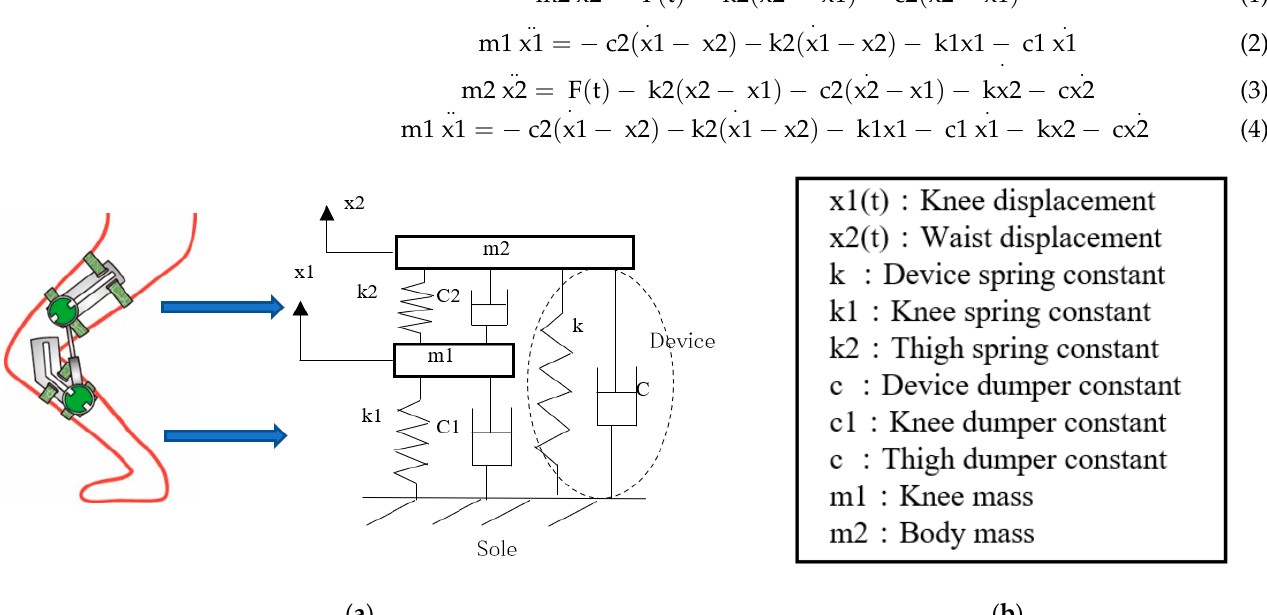
Figure 13. ( a ) Schematic of knee and device modeling. ( b ) Meaning of the symbols. Based on the model equations, the effects of the spring constant and damper coefficient on the knee were investigated. Figure 14 shows the basic results. Figure 14 does not show the device attached; a step-like load is input from 2 s. In the figure, the displacement of the knee and the force applied to the knee are shown. When the device is not installed, the knee displacement is about 9 cm, and the force is about 0.8 N.